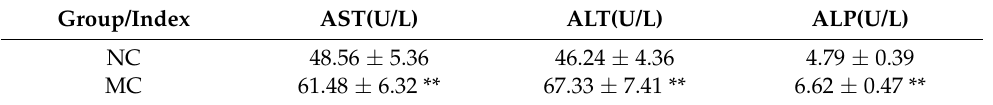
Table 1. Effects of cadmium exposure on AST, ALT, and ALP in the liver of mice.